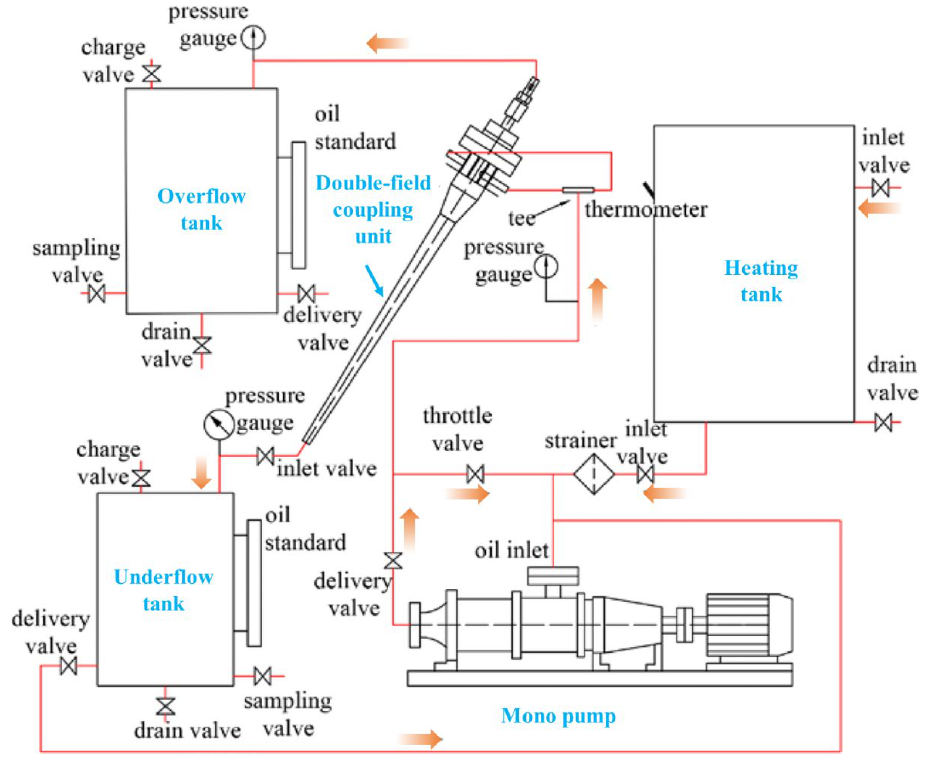
Figure 11. Heat-strengthening double-field demulsification process [190]. Reproduced with permis- sion of Peng Y et al., (ref. [190]). Creative Commons Attribution 4.0 International License.